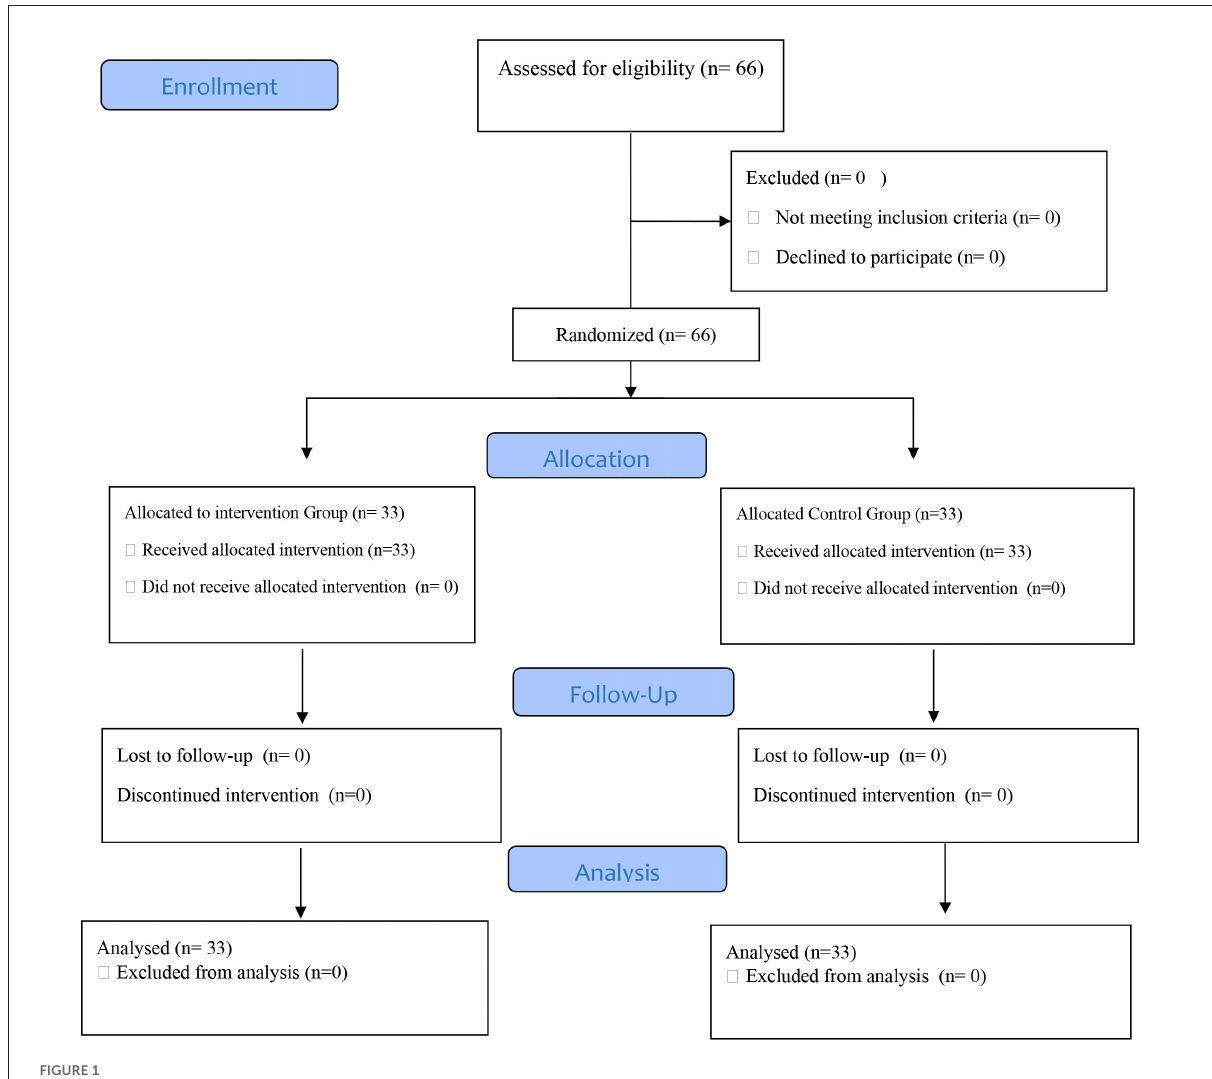
FIGURE1 The Consort flowchart of patients participating in the study.